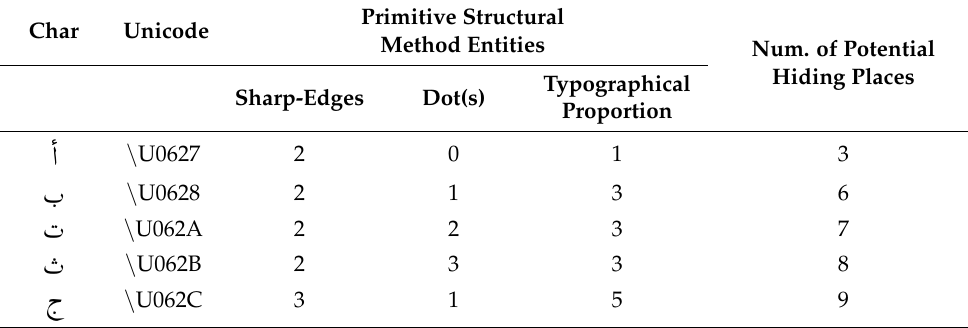
Table 15. Number of sharp edges for each letter (Adapted from